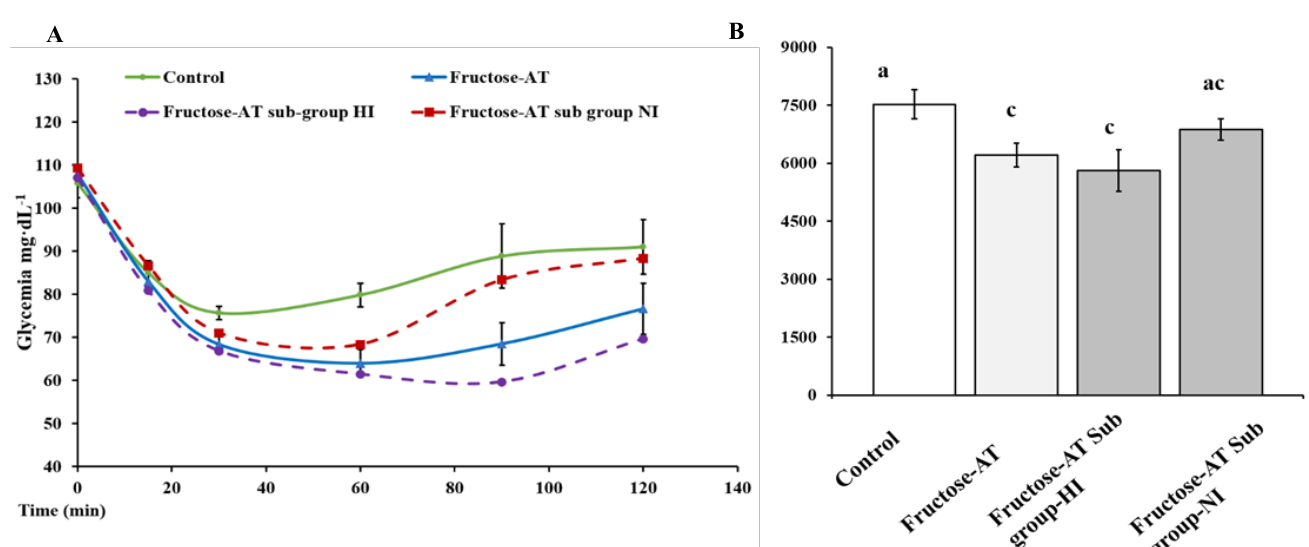
Figure 5. Specific analysis of the two subgroups of the Asteraceae infused drink. (A) Insulinemia; (B) Hepatic glucose-6-phosphatase activities. Subgroup-HI (high insulinemia) ( n = 5); subgroup-NI (normal insulinemia) ( n = 3). Different letters (a, b, and c) indicate significantly differences from each ( p < 0.05).